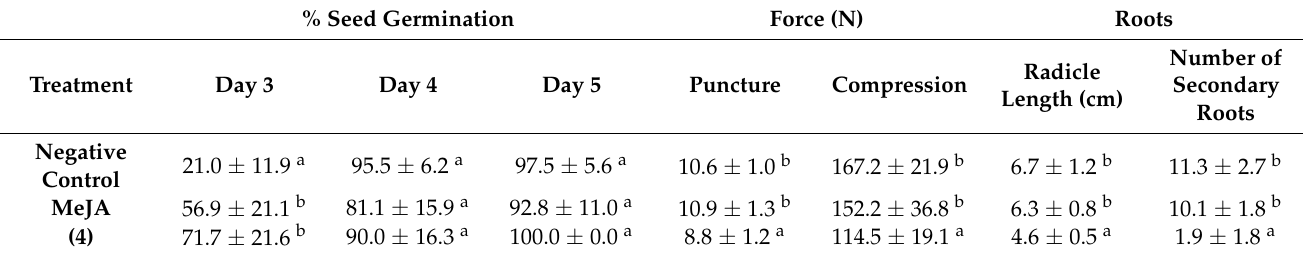
Table 1. Effect of spraying with 1-oxo-indanoyl-L-isoleucyl methyl ester ( 4 ) and MeJA on seed germination (%), cotyledon hardness (puncture and compression tests), and radicle number and length of common bean ( P. vulgaris L. cv. Uribe Rosado). All values are presented as mean ± standard deviation ( n = 3); for each trial, eight seeds were